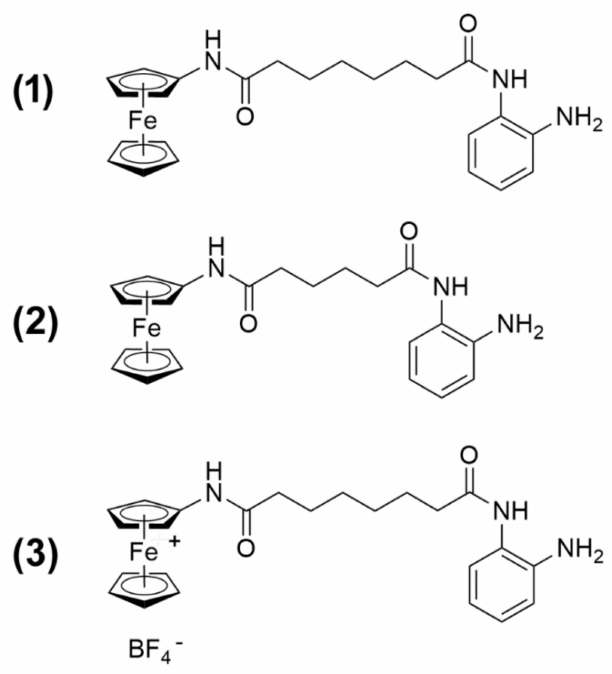
Figure 1. Compounds used in the present